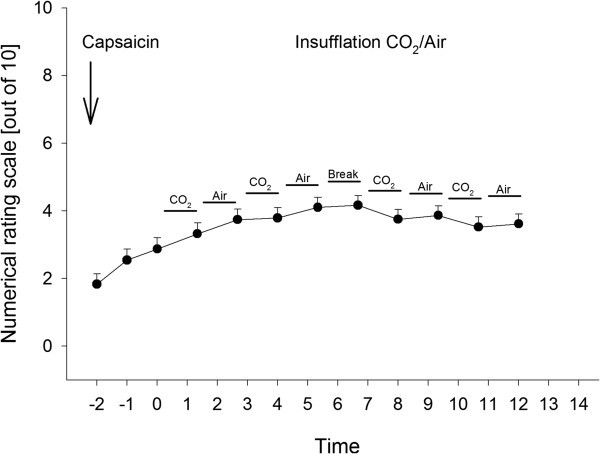
Alternating insufflation of CO2 and air after administration of capsaicin. Pain ratings on a numerical rating scale from 0 to 10 during nasal insufflation of CO2 with a flow of 1 l/min or compressed air for 60 sec each followed by an interval of 20 sec to change gas supply and pain rating after intranasal application of capsaicin. After 2 cycles of CO2 and air each a break of 60 sec was made to allow subject to remove nasal discharge due to intranasal capsaicin application. Time is given in minutes. Error bars are given as standard error of the mean.